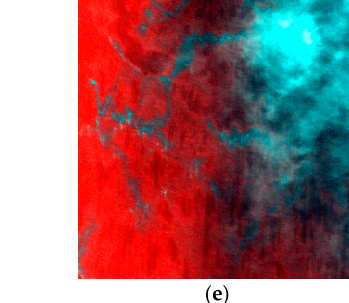
Figure 20. The reconstructed images obtained using the preprocessing algorithms and MVSA combinations. ( a ) Original image; ( b ) DSPP reconstructed image; ( c ) SPP reconstructed image; ( d ) RBSPP reconstructed image; ( e ) SSPP reconstructed image.